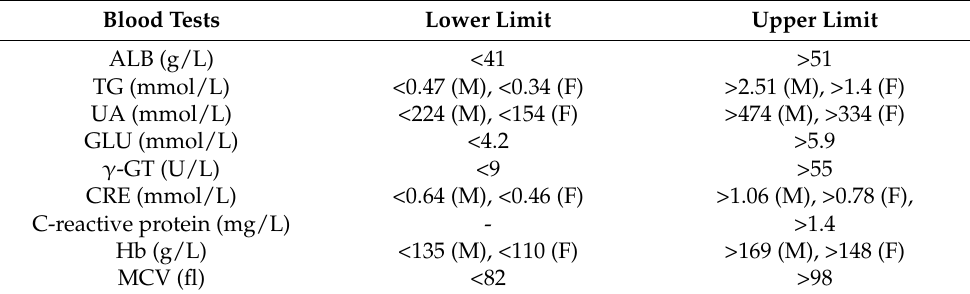
Table 2. The exclusion criteria of the blood